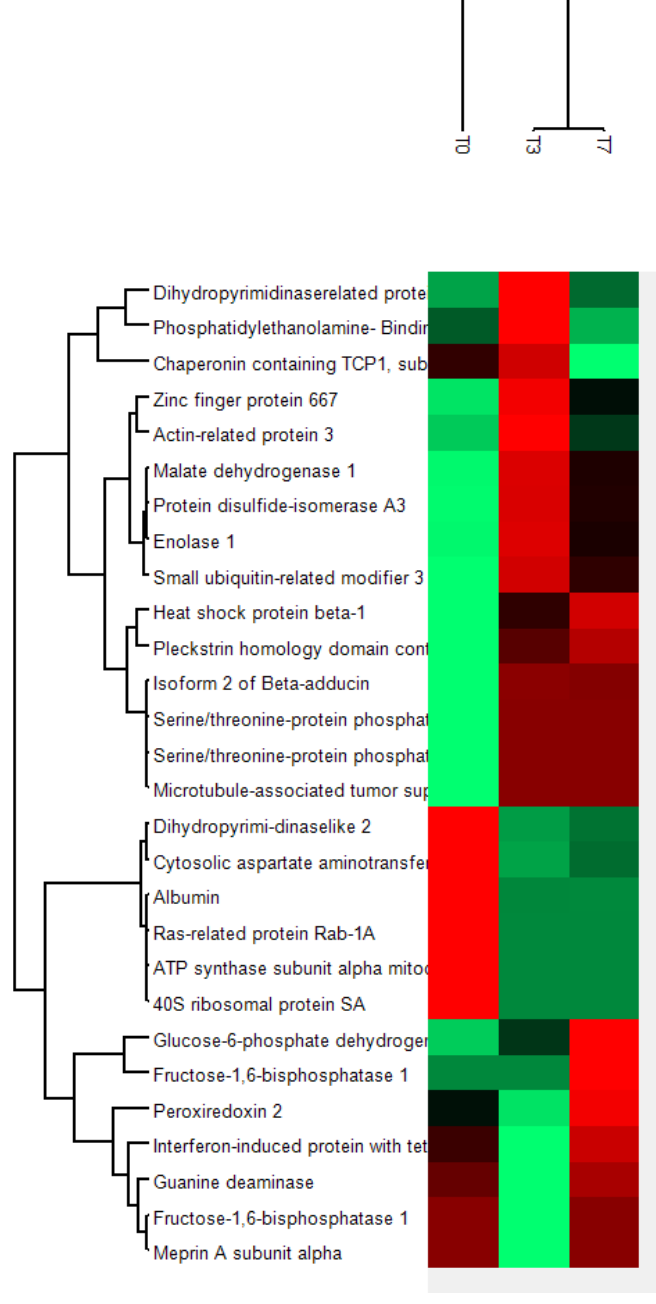
Figure 5. Heatmap generated by PERSEUS ® . The groups T3 and T7 show comparable regulation and are, therefore, grouped together. Green fields indicate up-regulation and red fields down-regulation.